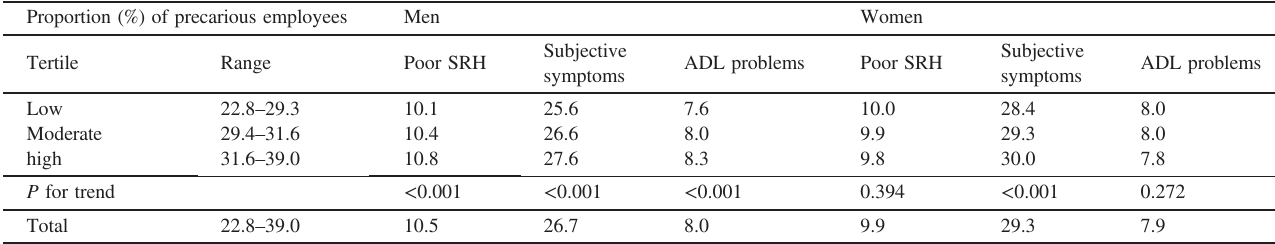
Table 3. Prefecture-level proportions of precarious employees and health outcomes Proportion (%) of precarious employees Men Women